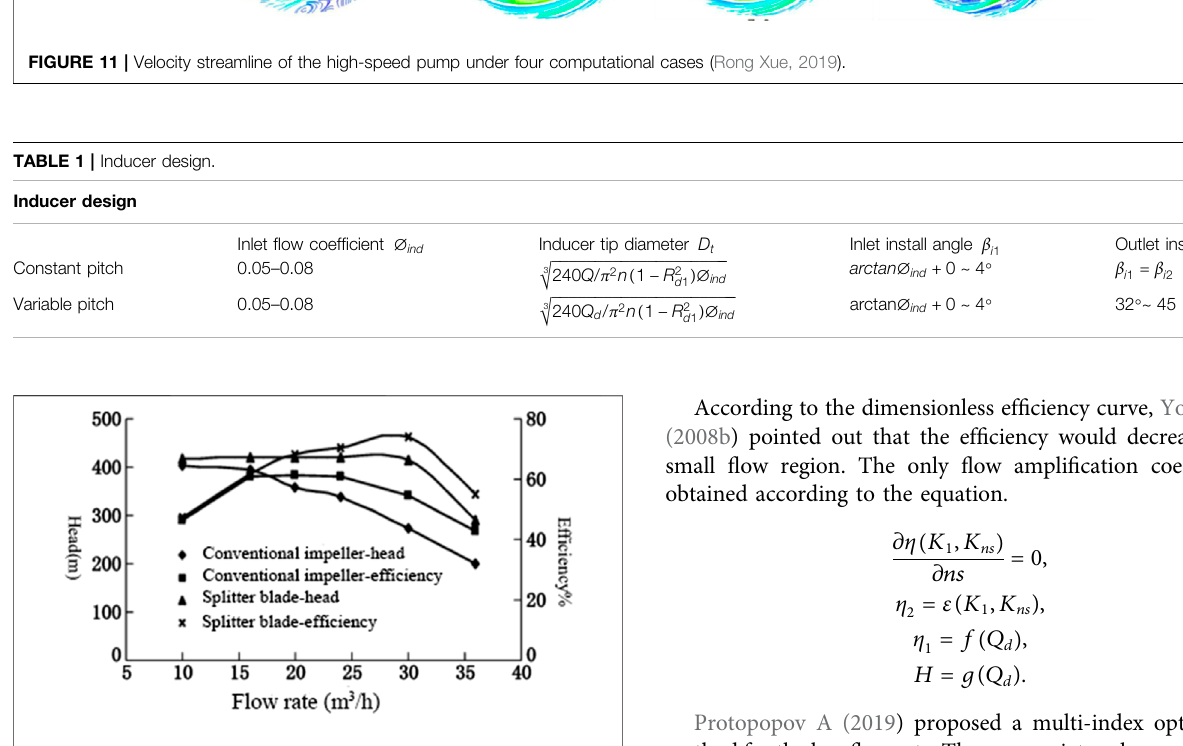
FIGURE 12 | Performance curve of the head and ef fi ciency (Xueyi Qi, 2009b).